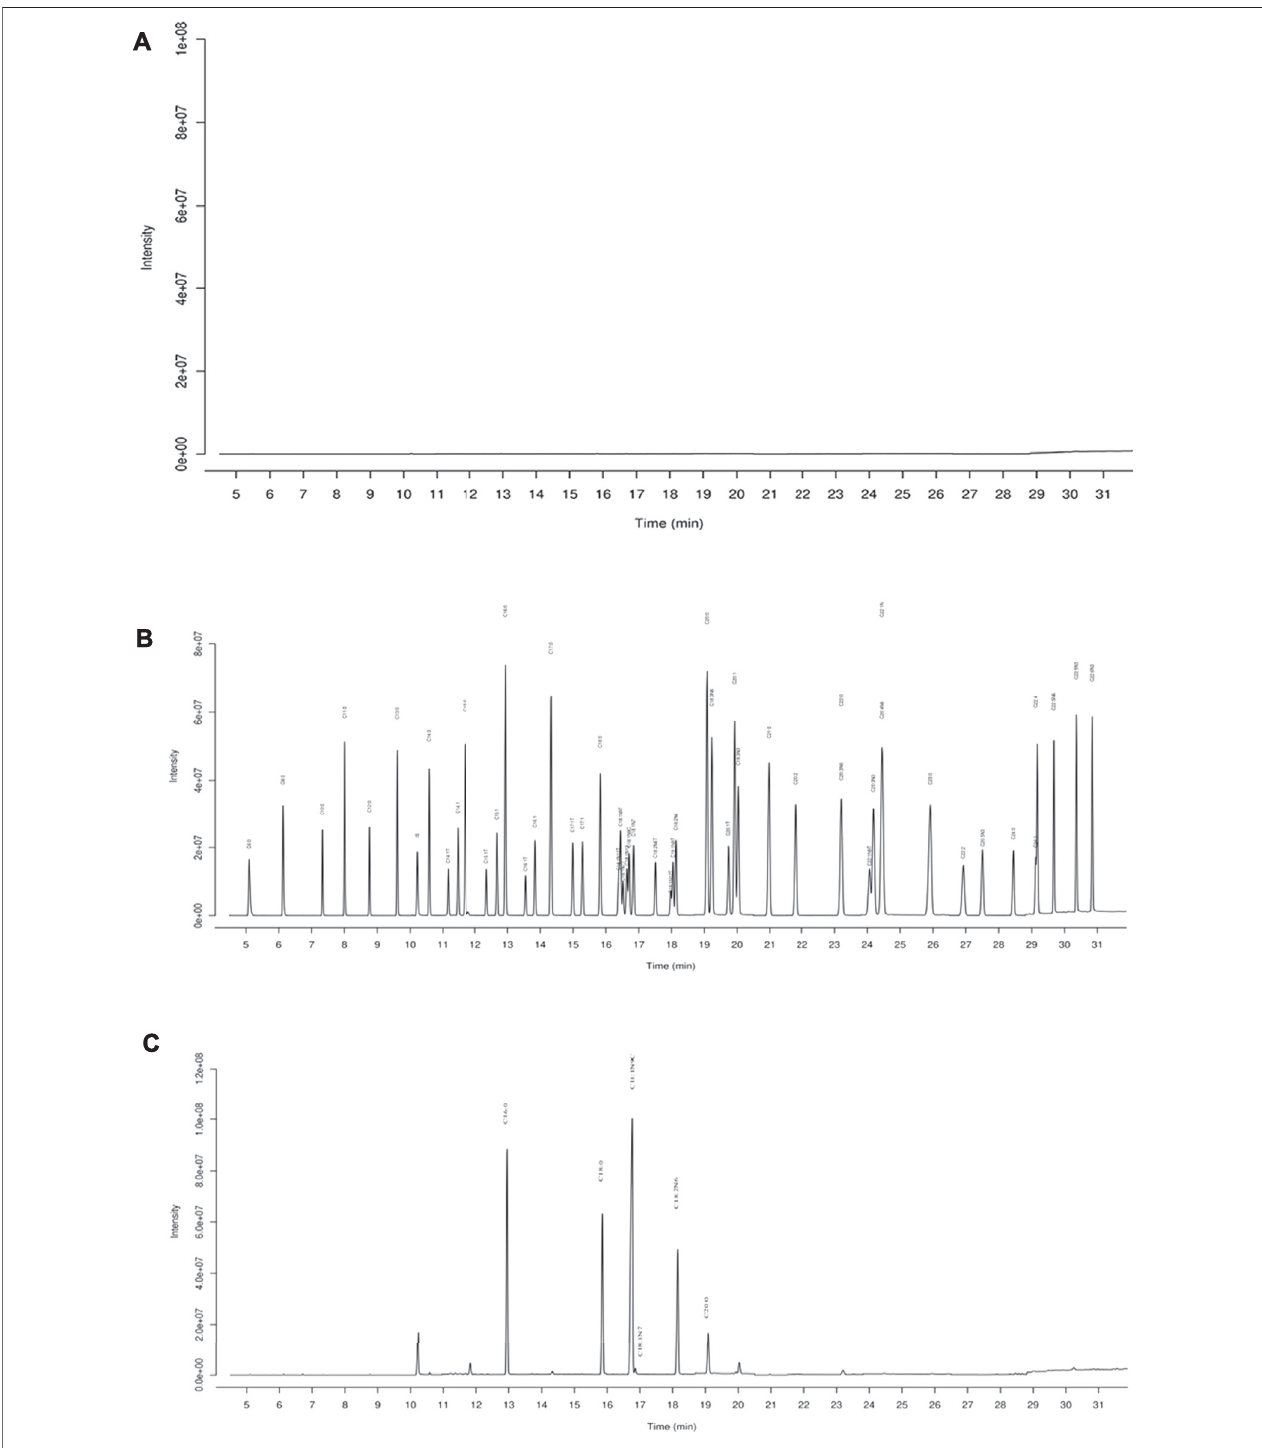
FIGURE 1 | GC-MS chromatography for chemical analysis of BO. (A) Blank, (B) standards of fatty acid, (C) BO. C16:0 (12.94 min), palmitate; C18:0 (15.83 min), stearate; C18:1N9C (16.71 min), Oleate; C18:1N7 (16.84 min), vaccenate; C18:2N6 (18.14 min), linoleate; C20:0 (19.09 min), and arachidate.